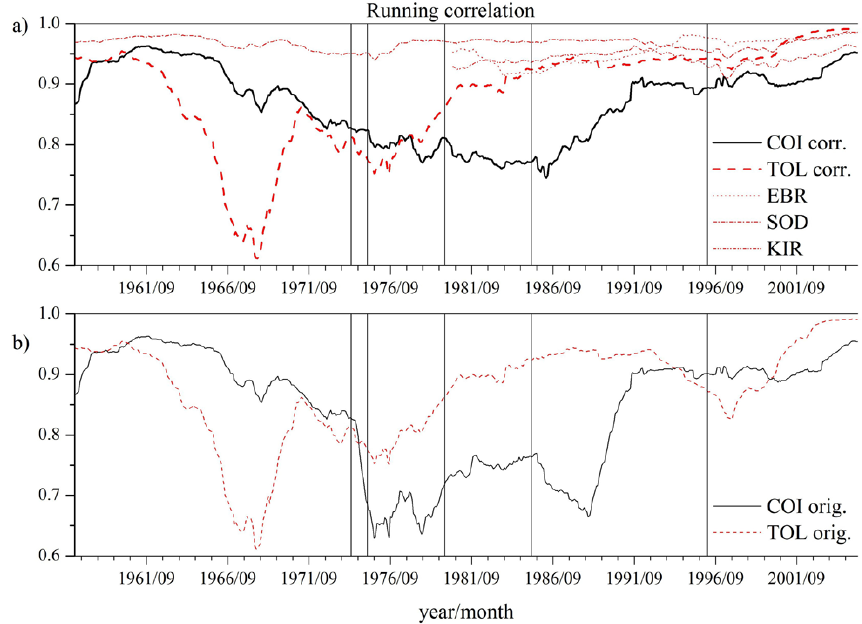
Fig. 7. Running correlation (window width 132 months = 11yr) between the Ki series from five stations and Kp: (a) corrected COI, corrected TOL, EBR, SOD and KIR Ki series, (b) original COI and original TOL Ki series. Vertical lines mark periods of possible homogeneity breaks for COI data (see Table